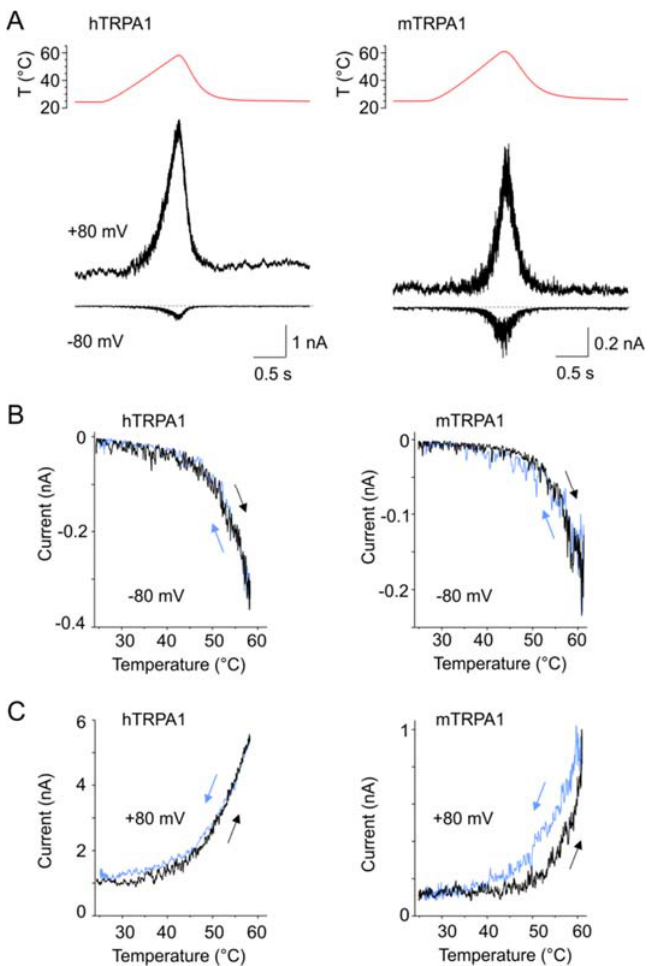
Figure 5. TRPA1 was directly and reversibly activated by heat at positive and negative membrane voltages. ( A ) Representative whole-cell currents of hTRPA1 (left) and mTRPA1 (right) activated by a temperature ramp (shown above the current traces) applied at a maximum speed of about 35 ◦ C / s and at constant holding potentials + 80 and − 80 mV. ( B , C ) Currents measured at ( B ) − 80 mV or ( C ) + 80mV, as in ( A ), plotted as a function of temperature. The arrows indicate the direction of temperature increase (black) or decrease (blue). Note that the paths followed by activation and deactivation were almost identical, i.e., the activation–deactivation was accompanied by a low degree of hysteresis. Typical examples are shown for four (mTRPA1) and five (hTRPA1) similar recordings.